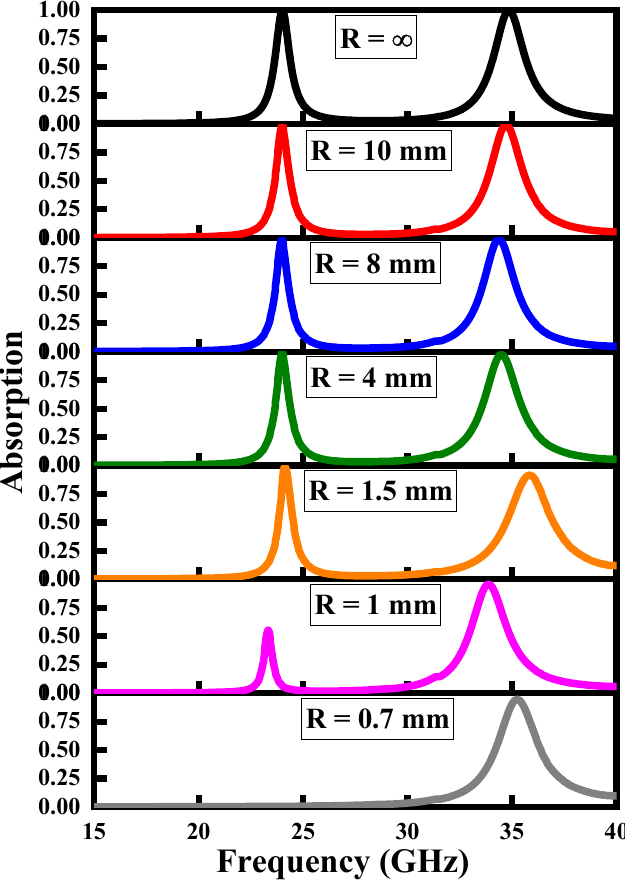
Figure 4. Bending analysis of the absorption rate of the proposed MMA at different radii of an arbitrary cylinder. R = ∞ shows no bending conditions, whereas R = 0.7 mm indicates extreme bending conditions.